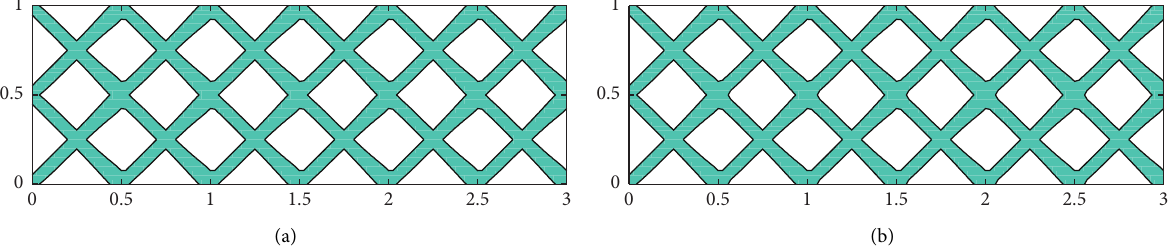
Figure 13: The initial designs for the MBB problem: (a) the QVT method and (b) the paper method.